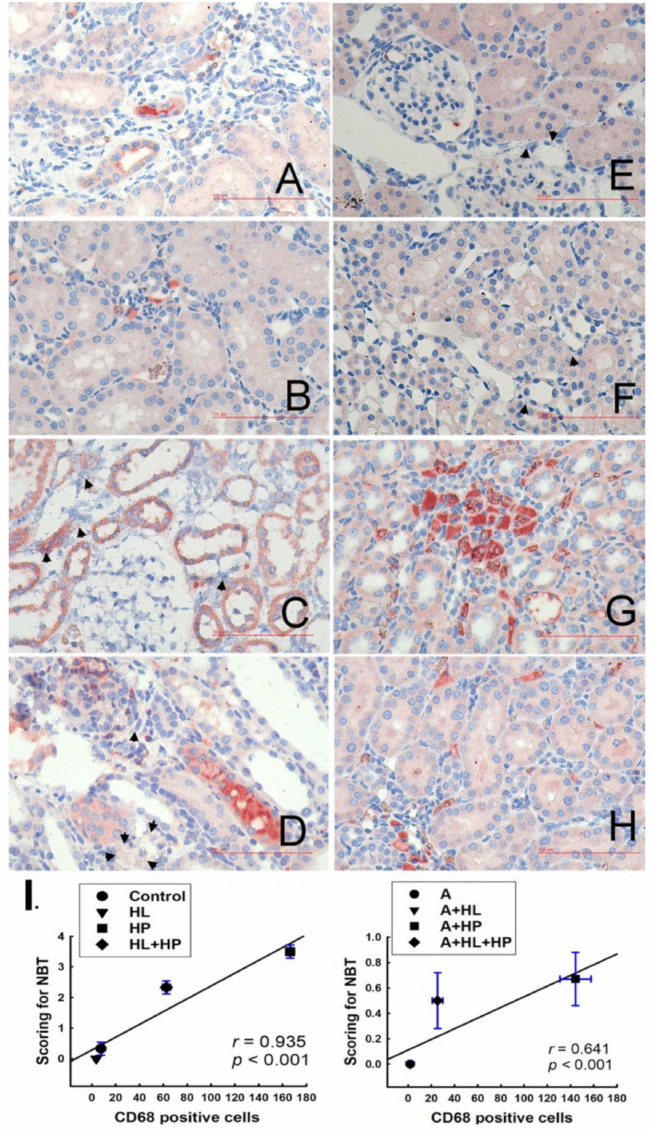
Figure 4. Representative micrographs of renal sections double staining for in situ superoxide for- mation (indicated by NBT, blue formazan particles, black arrowheads) and CD68 (monocyte and macrophage marker) immunostaining. Left panel: A – D : Non-A (Atorvastatin) experimental groups; Right panel: E – H : A-treated experimental groups. ( A ) Control group: only a few orange-red stained CD68-positive cells with NBT score of 0+. ( B ) Hyperlipidemia (HL) group: 3–5 CD68-positive cells in the interstitium, with NBT score of 0+. ( C ) Rats treated with 5% hydroxyproline (HP): CD68-positive cells located in dilated renal tubule cells and widened interstitium, with NBT of 3+-4+. ( D ) HL+HP group: many CD68-positive cells located in the interstitium with NBT score of 2+-3+ ( E ) A group: 1–5 CD68-positive cells in the glomerulus, with NBT score of 0+. ( F ) A+HL group: 1–5 CD68-positive cells, with NBT score of 0+. ( G ) A+HP group: many dark-stained CD68-positive cells in the interstitium, with NBT score of 0+-1+. ( H ) A+HL+HP group: 15–30 CD68-positive cells, with NBT score of 1+. All images above were demonstrated with original magnification 400 × . ( I ) Relationship